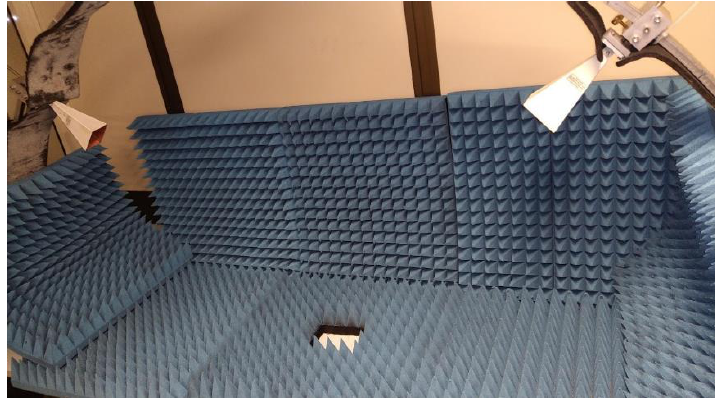
Figure 1. NRL ARCH setup, with horn antennas and anechoic panels.